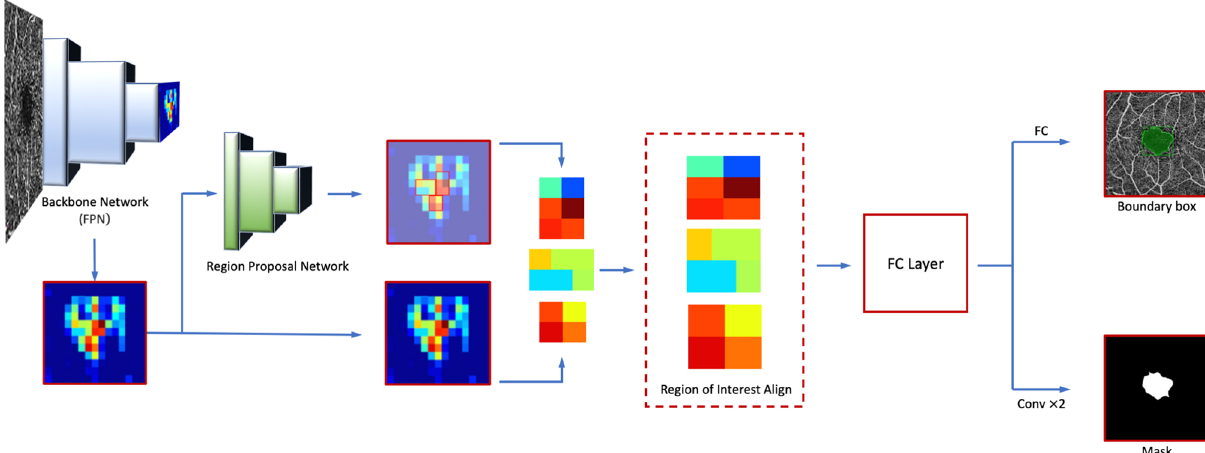
Figure 1. Simplified flowchart of the deep learning model simulating the steps for a single image.